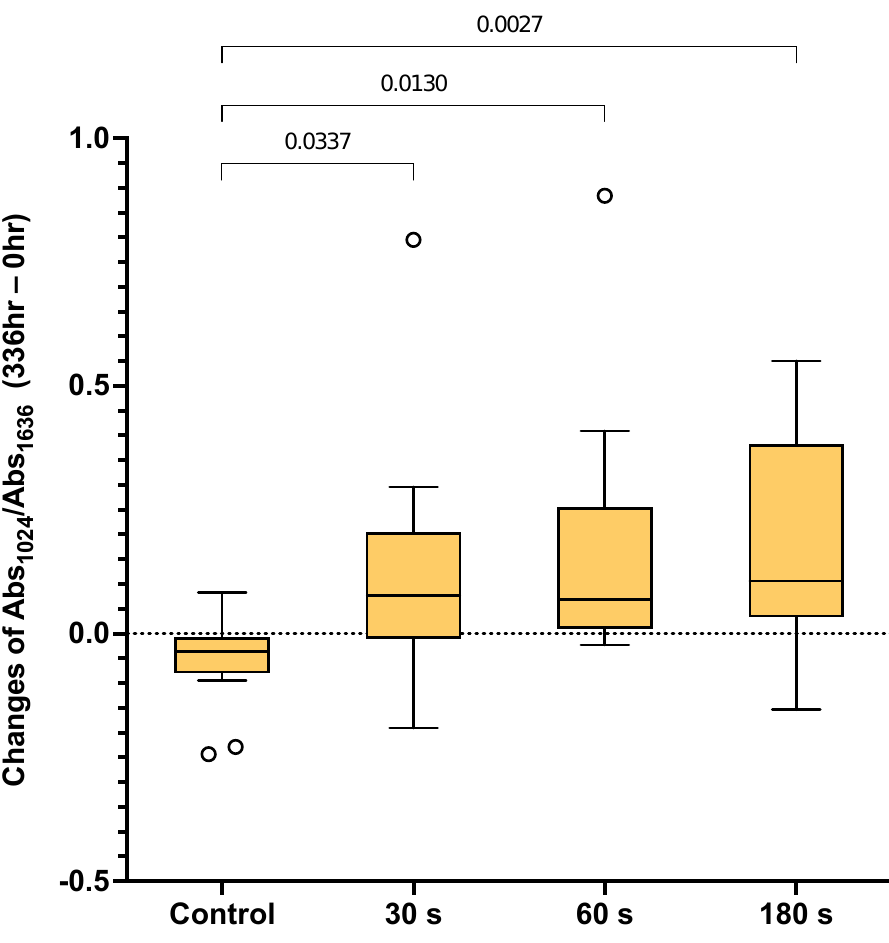
Figure 3. Box plots of the differences in Abs 1024 /Abs 1636 after 2 weeks compared with the initial value (336 vs. 0 h). The boxes represent the first quartile (Q1) to the third quartile (Q3), the horizontal lines in the box represent the median, and the whiskers represent the maximum and minimum values (n = 13). The line indicates p < 0.05. Circles are outliers.